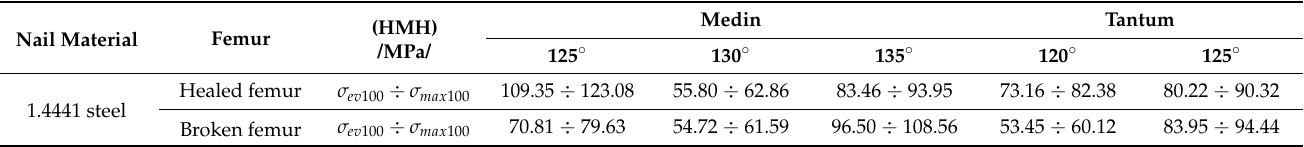
Table 6. Stress values at F = 980.7 N.